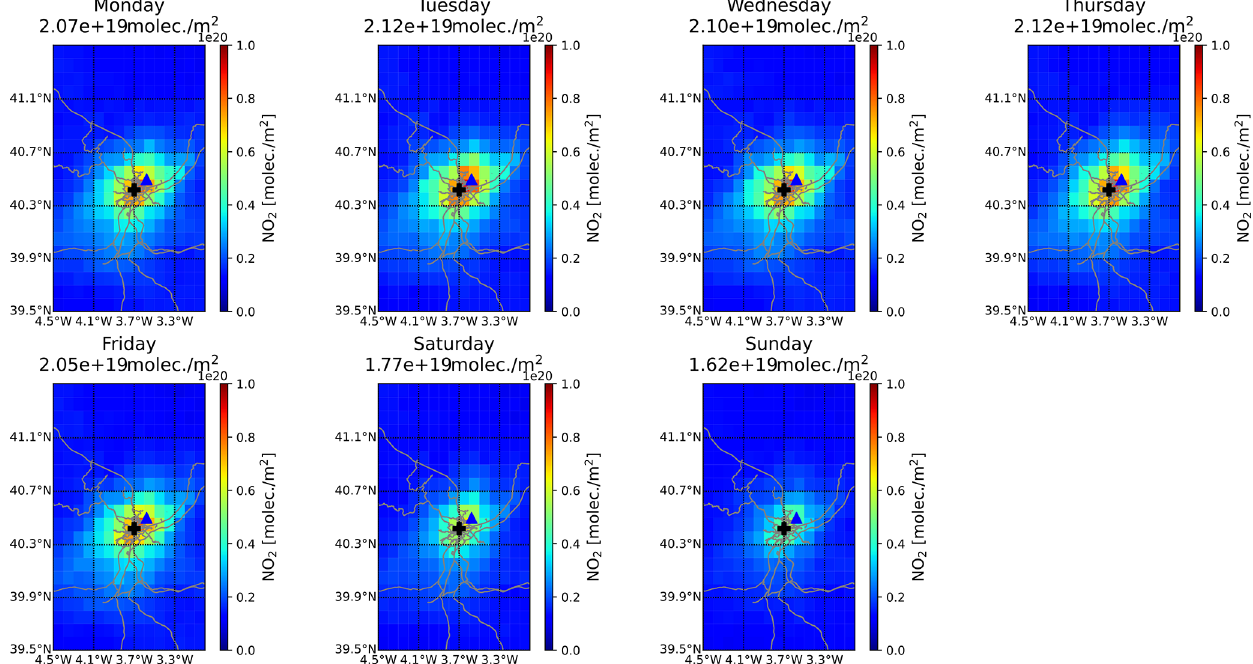
Figure A9. The same as Fig. A7 but for the Madrid